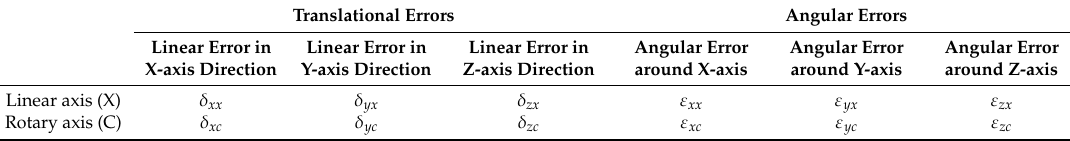
Figure 1. Error model of a five-axis computer numerical control (CNC) machine tool: ( a ) Five-axis CNC machine tool; ( b ) Error model of a linear axis (X); ( c ) Error model of a rotary axis (C). Table 1. Six-degrees-of-freedom (6DOF) geometric motion error definitions.